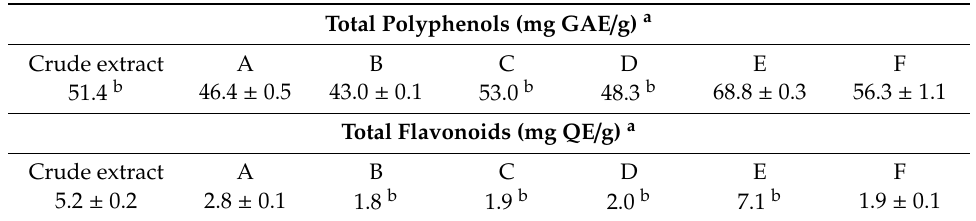
Table 1. Total polyphenols and total flavonoids content in Spathodea campanulata crude extract and fractions